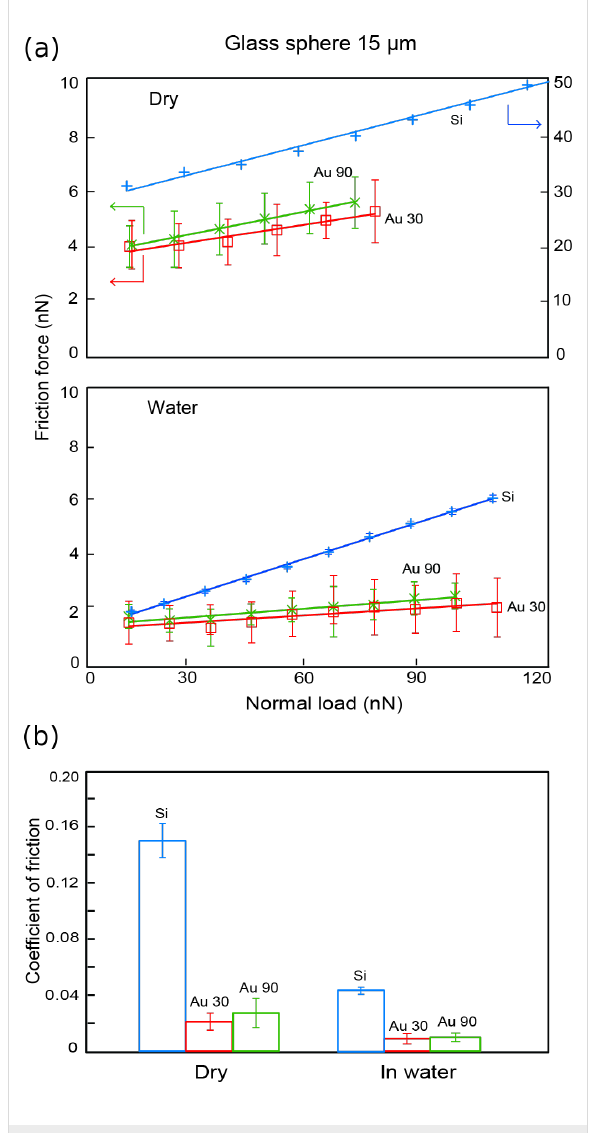
Figure 9: (a) Friction force as a function of normal load and (b) coeffi- cients of friction for both dry and in-water conditions, with and without Au